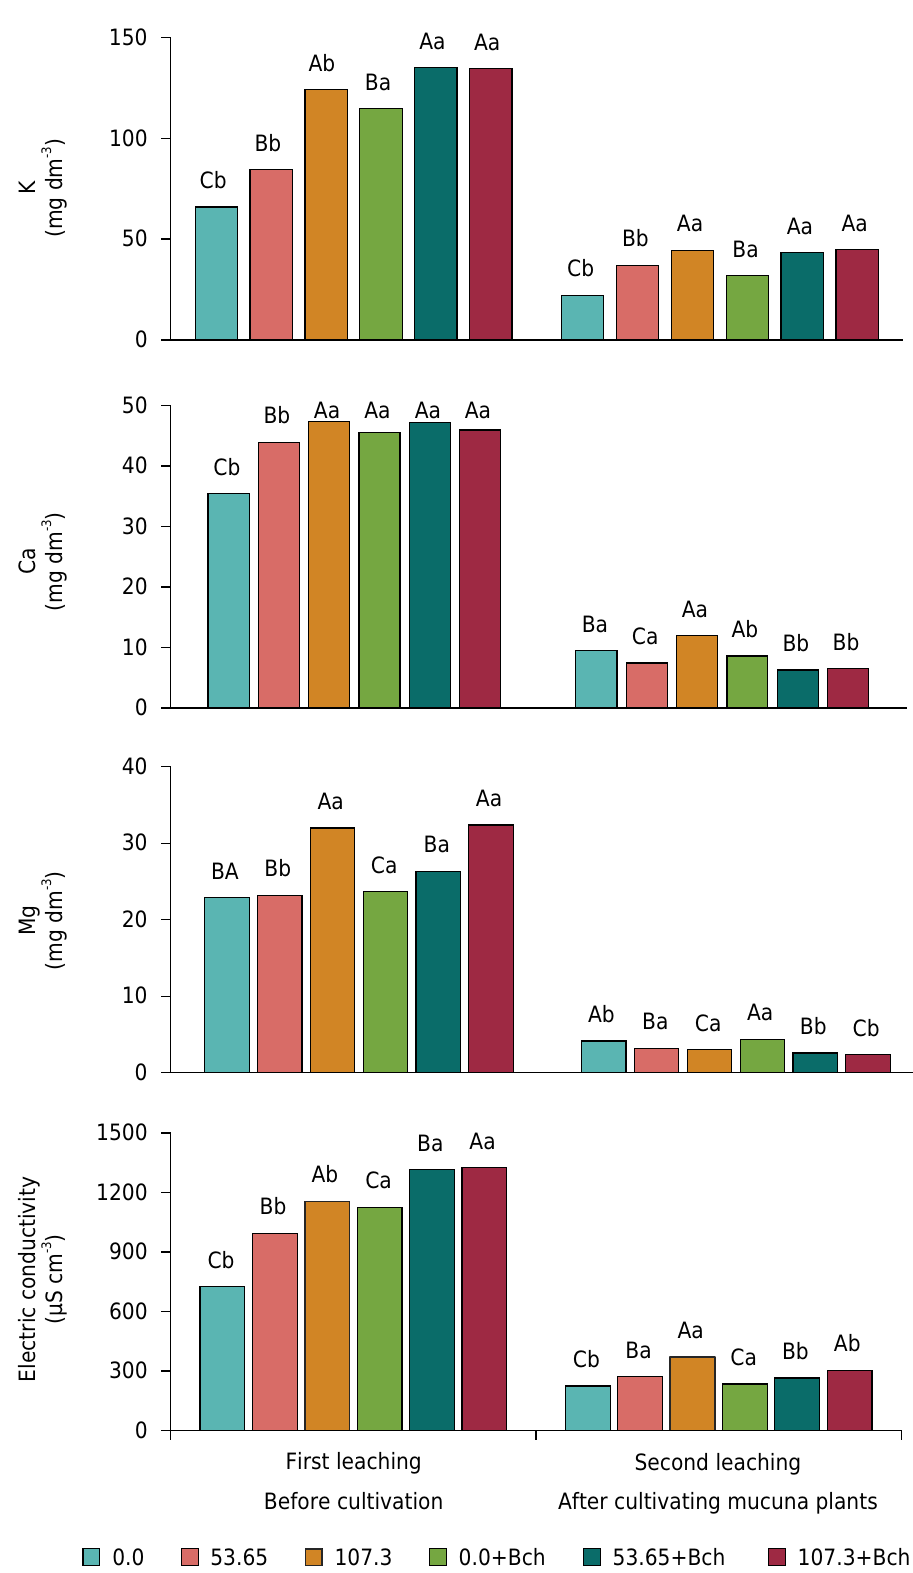
Figure 5. Potassium (a), Ca (b), Mg (c) and electric conductivity (d) in the water of the first leaching event (after incubation) and the water of the second leaching (after harvest of the mucuna) from soil treated with or without biochar associated with three doses of K (mg dm -3 ). Differences between the three K doses for treatments with or without biochar are indicated by capital letters. Differences between treatments with or without biochar at each dose of K are indicated by lowercase letters, both by the Tukey’s test at 5 % (mean of 6